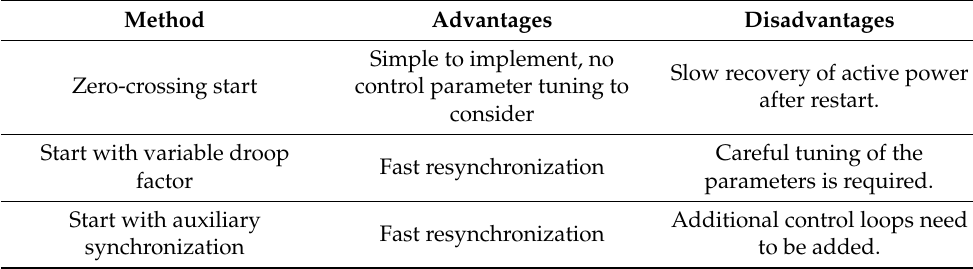
Table 2. Comparison of the proposed